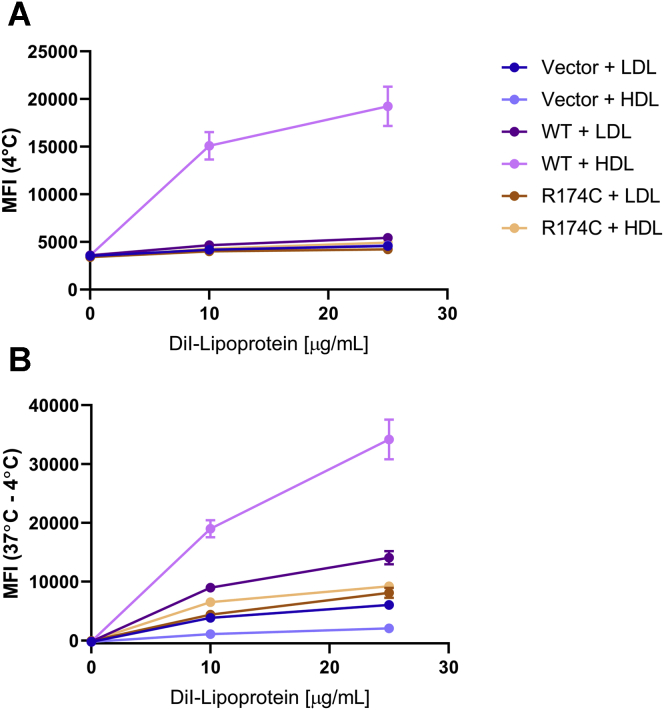
DiI-LDL internalization is reduced in the presence of R174C-SR-BI. COS-7 cells transiently transfected with empty vector, WT-SR-BI, or R174C-SR-BI were incubated with the indicated concentrations of DiI-LDL or DiI-HDL for 1.5 h at 4°C or 37°C. A: Mean fluorescence intensities (MFI) of DiI-LDL and DiI-HDL binding at 4°C are shown. B: DiI-LDL and DiI-HDL internalization were calculated as the differences between MFI at 37°C and MFI at 4°C that can be attributed to lipoprotein binding. Statistically significant differences, as determined by two-way ANOVA, are presented in Supplemental Table S2. Data represent the mean ± SEM of three independent transfections (n = 3) performed in duplicate.